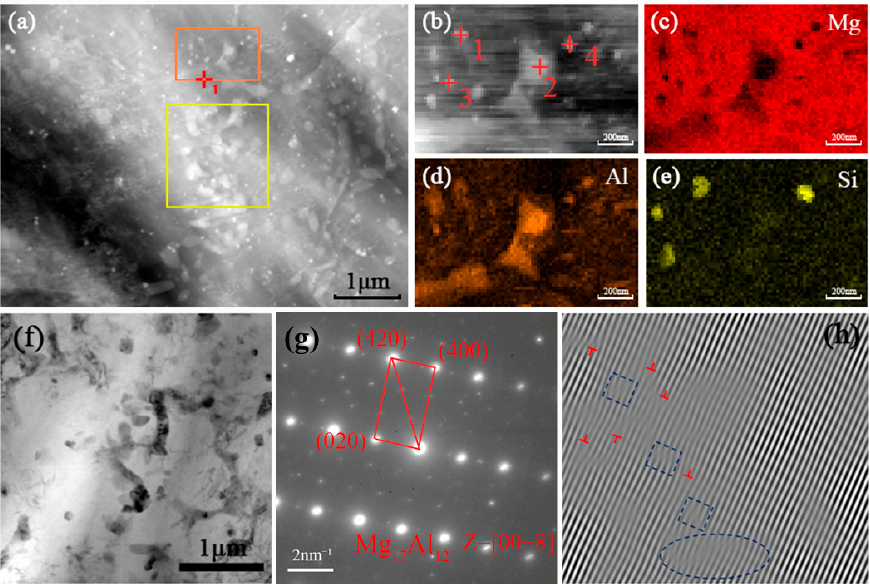
Figure 9. ( a ) STEM image of the second phase in AS41 sample, ( b – e ) chemical mapping, ( f ) TEM micrograph, ( g ) SAED pattern, ( h ) inverse Fourier filtered transform pattern.